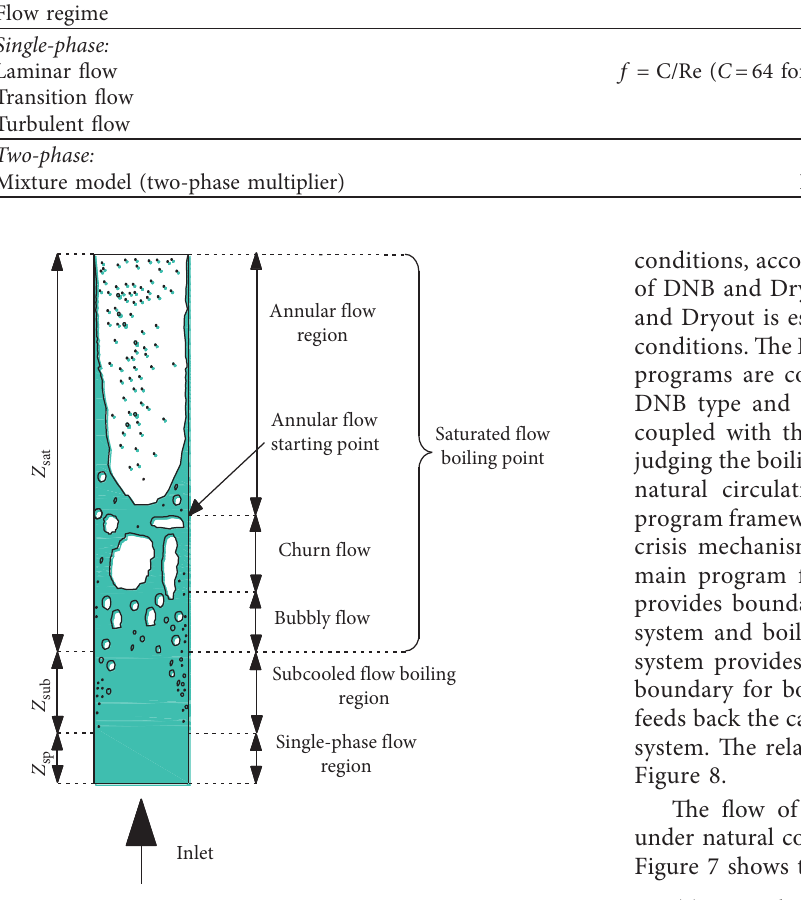
Figure 4: Schematic of flow patterns in a heated vertical